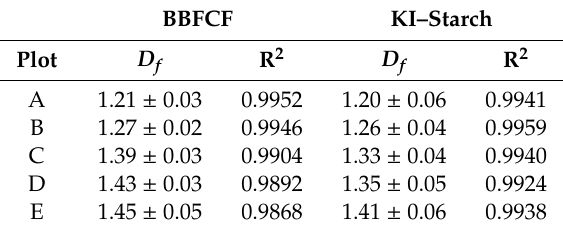
Table 4. Fractal dimension ( D f ) of the preferential flow wetting front curve in the two di ff erent dye tracer experiments for the (A) bottom–, (B) lower–, (C) mid–, (D) upper–, and (E) top–slope plots. BBFCF KI–Starch Plot D f R 2 D f R 2 A 1.21 ± 0.03 0.9952 1.20 ± 0.06 0.9941 1.27 ±